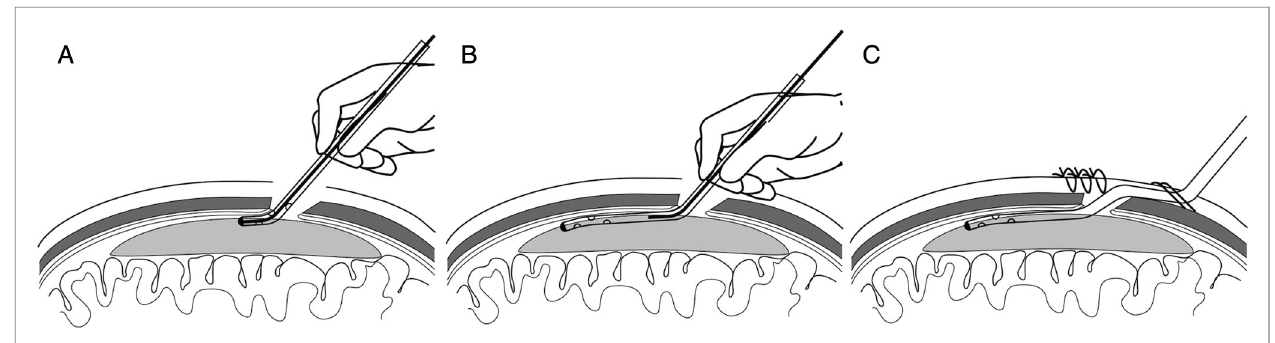
FIGURE 1 | Step-by-step procedure for the guidewire-assisted technique. ( A ) The catheter (14F) with the guidewire at an angle (about 135 degrees) was inserted into the bone hole. ( B ) With the wire navigation, the 4 – 5 cm catheter was slowly pushed into the subdural space toward the frontal direction. ( C ) The guidewire was slowly withdrawn. The catheter was tunneled subcutaneously and fi xed